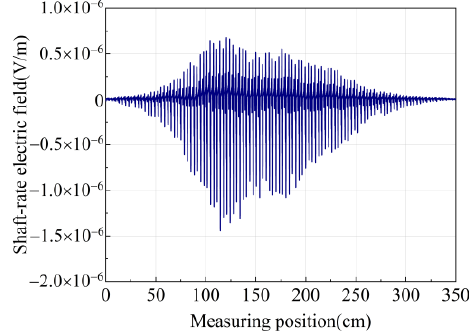
Figure 13. Experimental shaft-rate electric field signal.